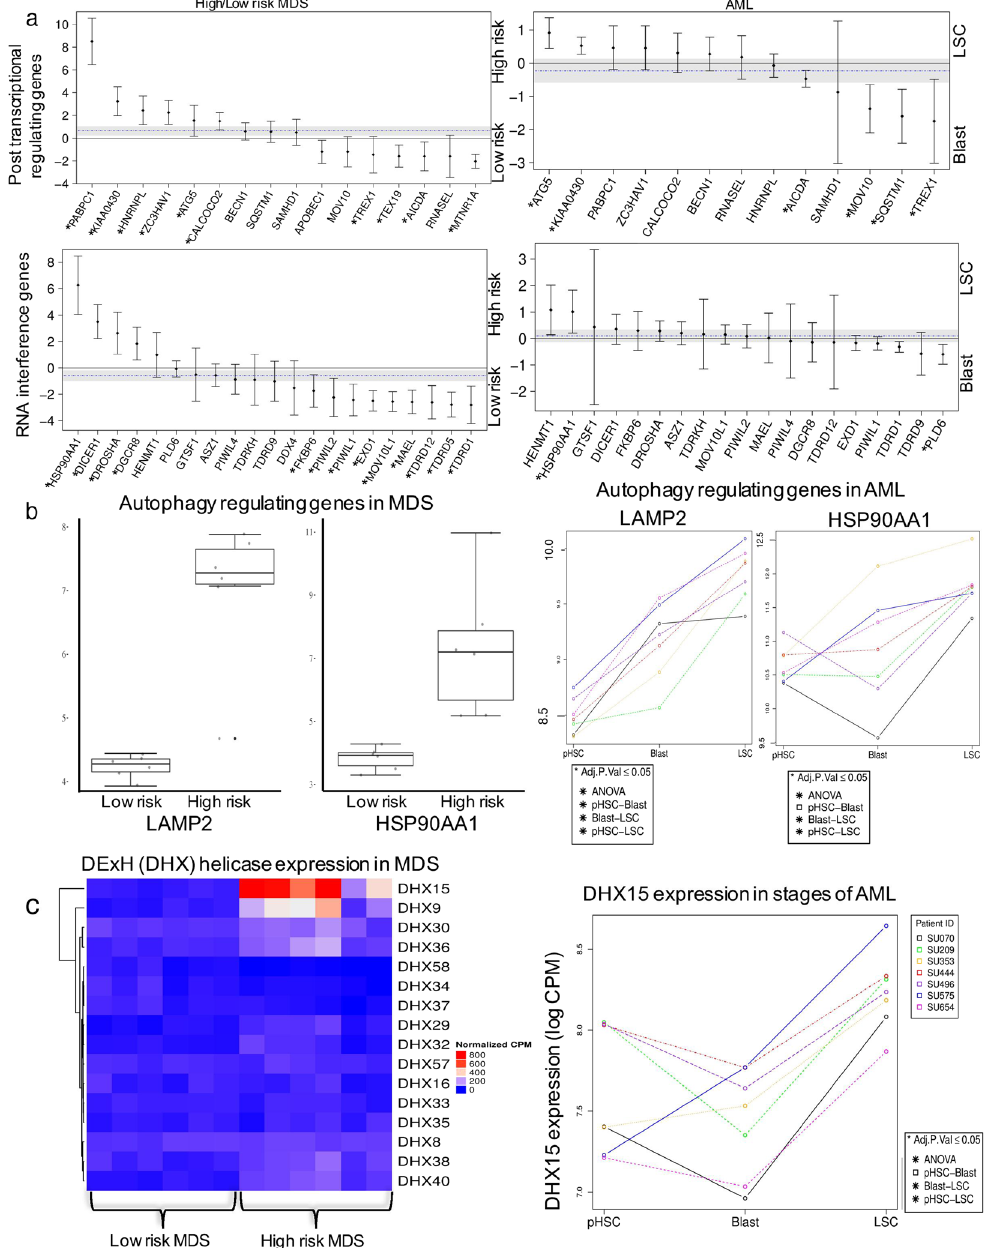
Figure 7. Expression of genes that modulate transposable elements post-transcriptionally ( a ) Genes that regulate TE post-transcriptionally. Positive fold-change (Y-axis; y > 0) indicates higher expression in high- risk MDS cases and/or LSCs. Negative fold-change (y < 0) indicates higher expression in low-risk MDS cases and/or Blasts. Significant genes are denoted with * p.value ≤ 0.05. ( b ) Autophagy-regulating genes in MDS and AML. Expression of LAMP2 and HSP90AA1 in high- and low-risk MDS cases and pairwise comparison of AML stages. Paired patient measurements are shown with matching colours. Adjusted significance values denoted * p.value ≤ 0.05 ( c ) Expression of RNA helicase genes, DExH genes. The heatmap depicts differentially expressed DExH genes in MDS cases. Expression of DHX15 in different stages of AML, where paired patient measurements are shown with matching colours. Adjusted significance values denoted * p.value ≤ Immuno-oncology is emerging as one of the cornerstones of treatment of various cancers. Interferons have long been used in the treatment of cancers, leading to sustained remissions 54–56 . However, it has been associated with significant systemic toxicities. Activating suppressed TEs, which are known to activate interferons, in cancer cells could potentially accomplish this in a targeted manner. Our study is the first to show dysregulation of TE in LSCs, revealing its importance in the pathogenesis of AML and MDS. Studying direct mechanisms of the regulation of cancer immunosurveillance by TEs in AML and MDS could lead to therapies improving long-term survival by manipulating the expression of TEs in leukemic cells.